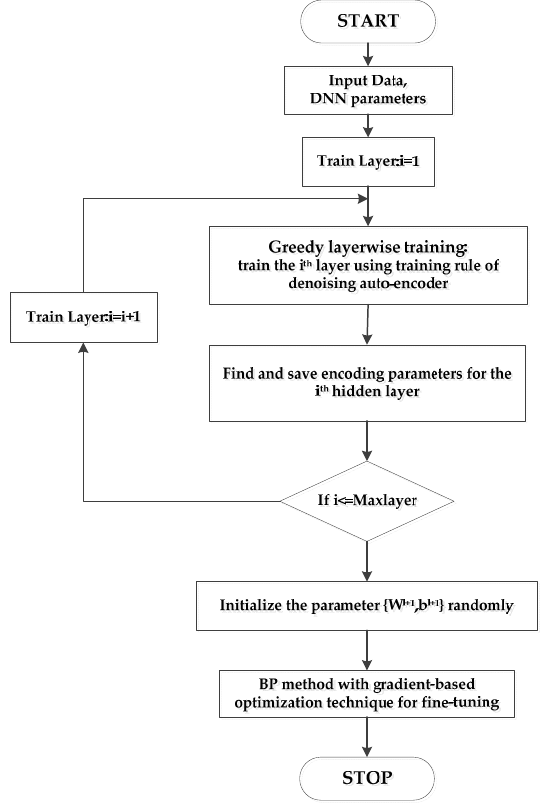
Figure 5. Procedure of DNN training process.